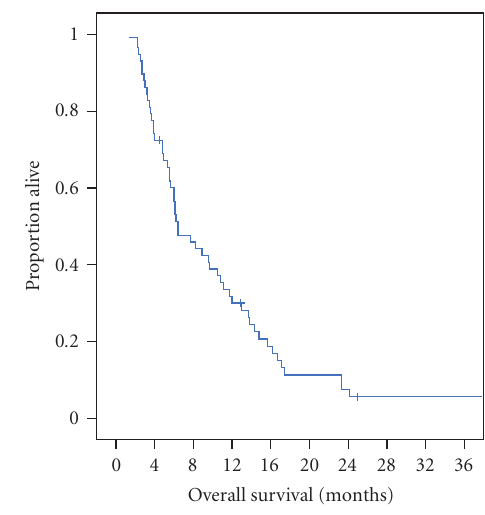
Figure 1: Progression-free survival curve for patients receiving vi- norelbine on this study (+ indicates censored patient).